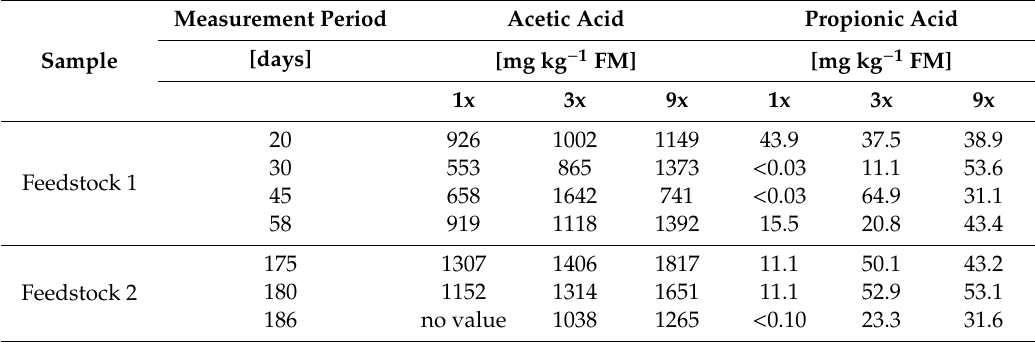
Table 4. The concentration of acetic acid and propionic acid (mg kg − 1 FM) in the semi-continuous digestion processes. The results represent the data from feedstock 1 and 2.